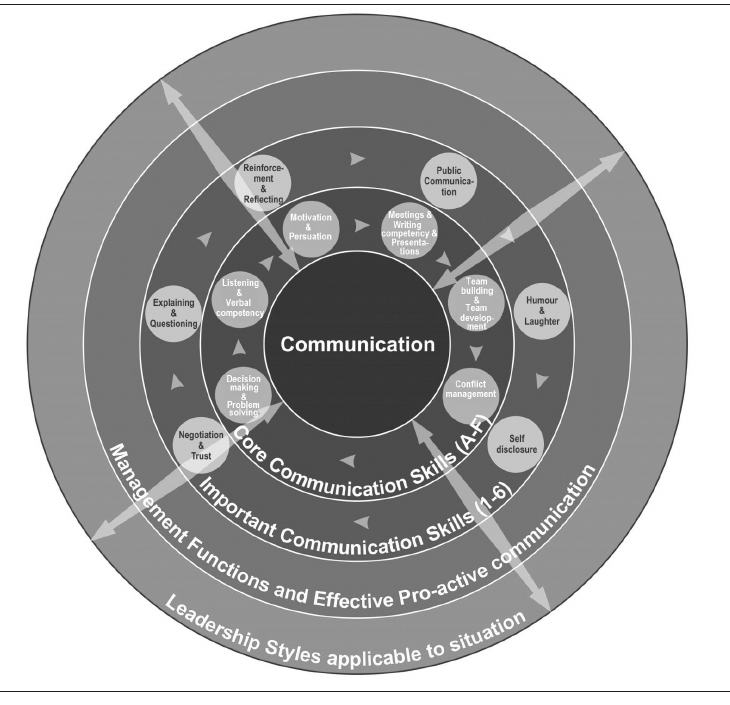
Figure 1: Communication skills and leadership model for construction project management